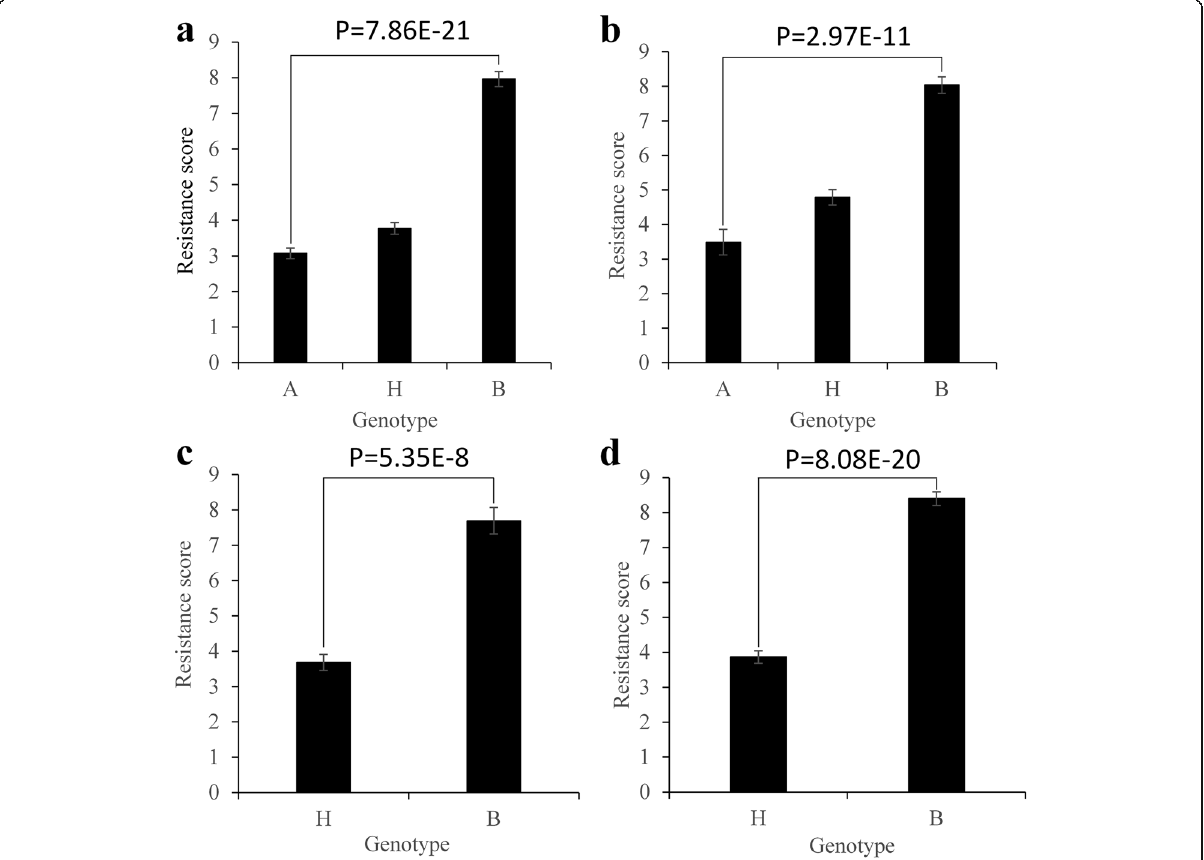
Fig. 3 Comparison of resistance levels among different Bph33 genotypes in four populations. a and b In the BC 1 F 2:3 populations from 9311 × KOLAYLA ( a ) and 9311 × POLIYAL ( b ); c and d In the BC 2 F 1 populations from 9311 × KOLAYLA ( c ) and 9311 × POLIYAL ( d ). The Bph33 genotype was identified according to its flanking markers H25 and D17. A, KOLAYLA or POLIYAL genotype; B, 9311 genotype; H, heterozygote genotype. P - values are shown for the comparison between A and B (in a and b ) or between B and H (in c and d